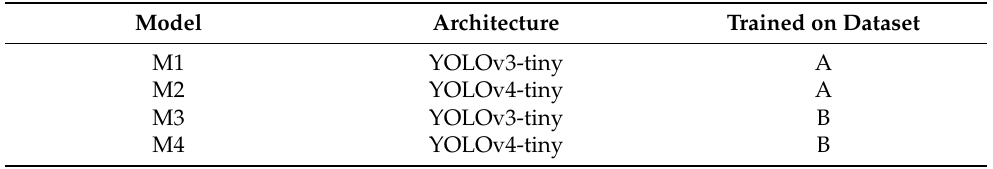
Table 3. A list of the four trained models, both tiny architectures of the YOLO neural network are trained on the two available datasets.